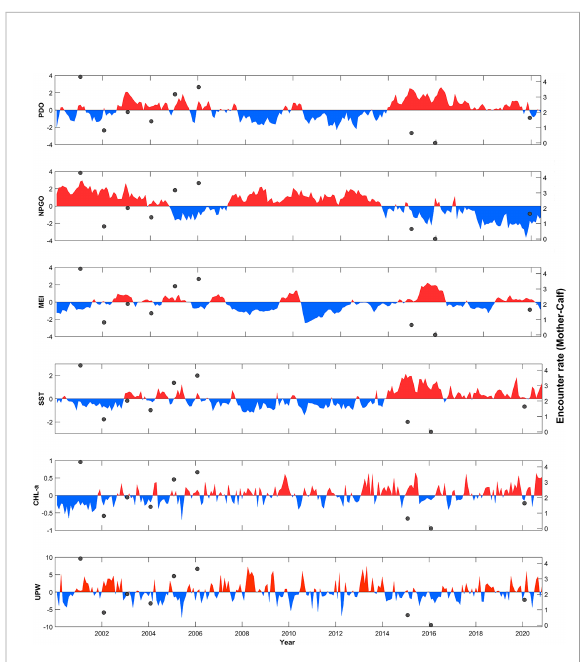
FIGURE 3 Monthly values of the Paci fi c Decadal Oscillation index (PDO), the North Paci fi c Gyre Oscillation index (NPGO), and the Multivariate ENSO Index (MEI) and anomalies of Sea surface temperature (SST), Chlorophyll a concentration (CHL-a), and the coastal Upwelling Index (UPW) obtained from the feeding grounds of humpback whales off California-Oregon-Washington in the United States (area graphs). Encounter rate of humpback whale mother-calf pairs recorded during the breeding season in the Osa Peninsula, Costa Rica (gray